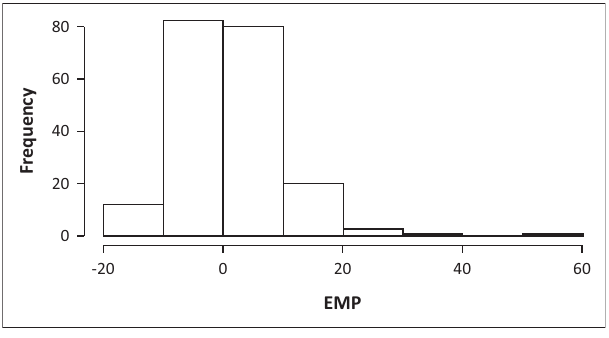
FIGURE 21: Kenya – Diagnostic plot for peak over threshold analysis: QQ-plot of the residuals. TABLE 12: Kenya – Estimated tail quantiles of the exchange market pressure index. Probability level